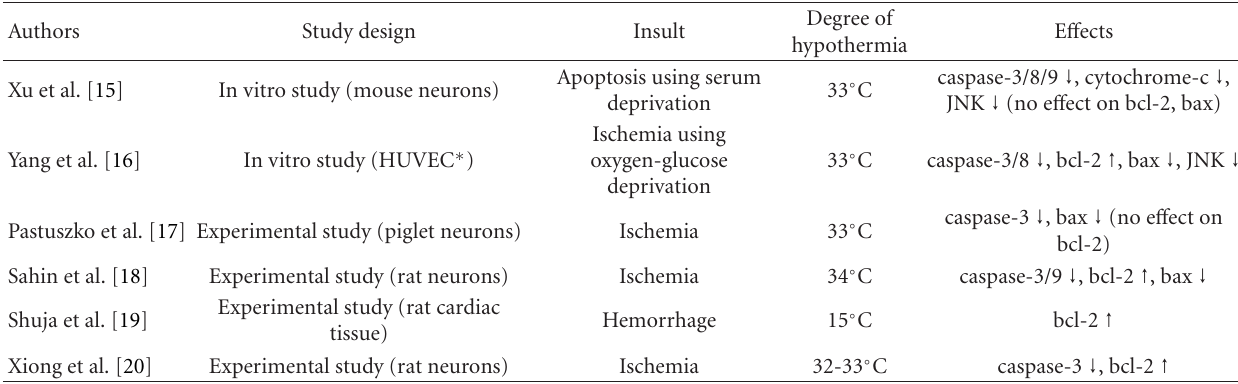
Table 1: E ff ects of hypothermia on apoptosis.